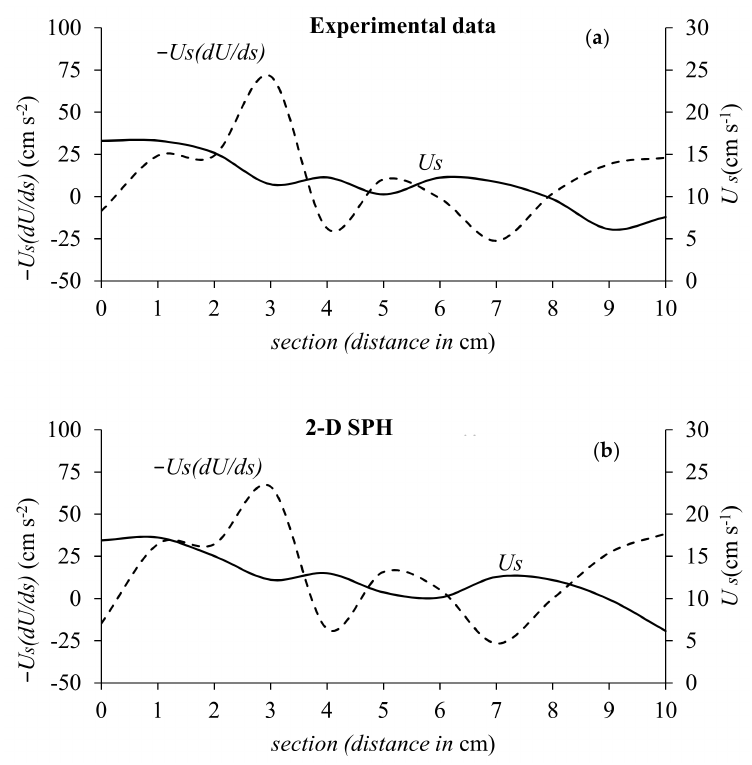
Figure 11. Free-surface velocity and deceleration term for ( a ) experimental and ( b ) numerical data. Then, the validated SPH model run to detail the vorticity field under the plunging breaker and to shed some light on the vorticity source. Three frames along the channel were examined,